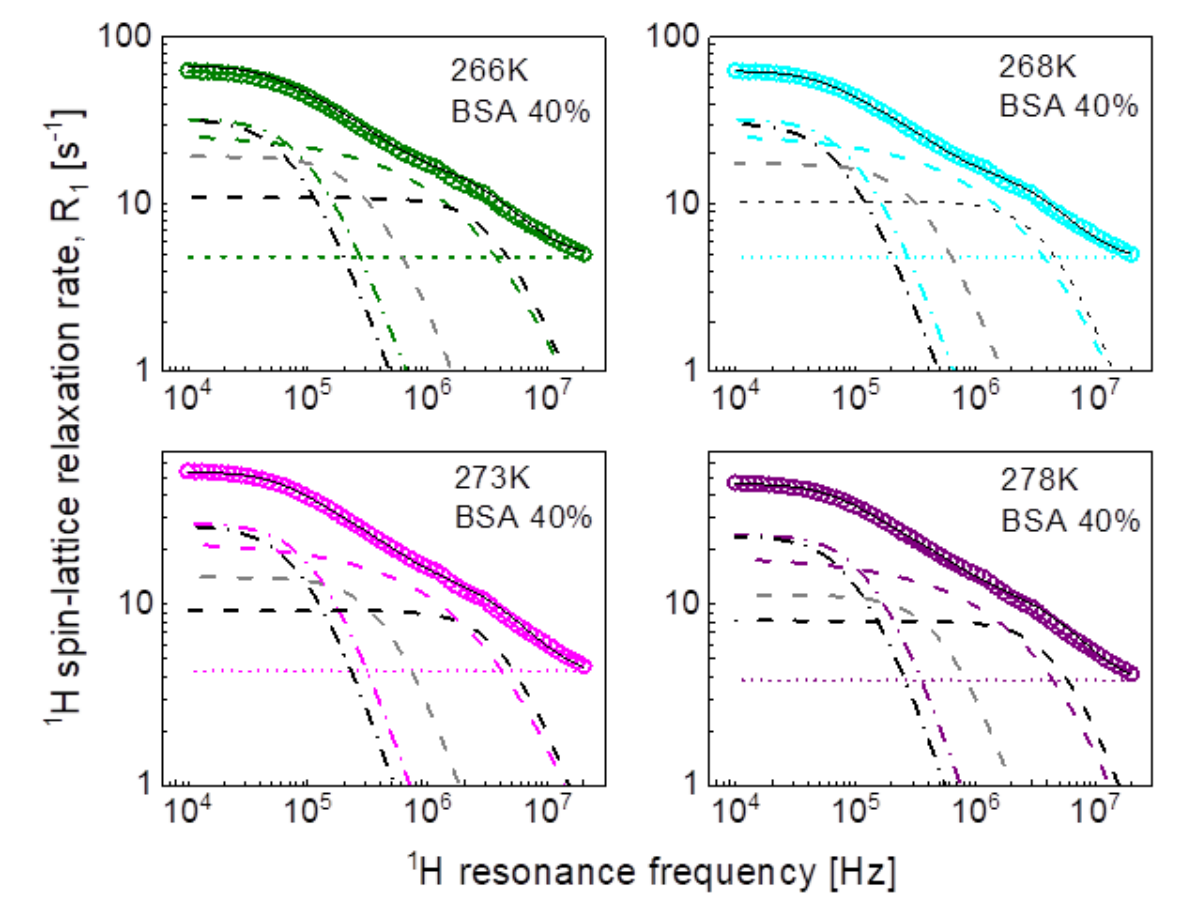
Figure 4. 1 H spin-lattice relaxation data for BSA–water mixture (40%wt of BSA) reproduced in terms of Equation (3); black solid line—overall fit decomposed into a contribution associated with slow dynamics (dashed-dotted black line), intermediate dynamics (dashed grey line), and fast dynamics (dashed black line). Comparison fits obtained in terms of Equation (5) are shown as the corresponding color lines, they are decomposed into a Lorentzian term (dashed-dotted line), a term associated with three-dimensional translation diffusion (dashed line) and a frequency independent term (dotted line).